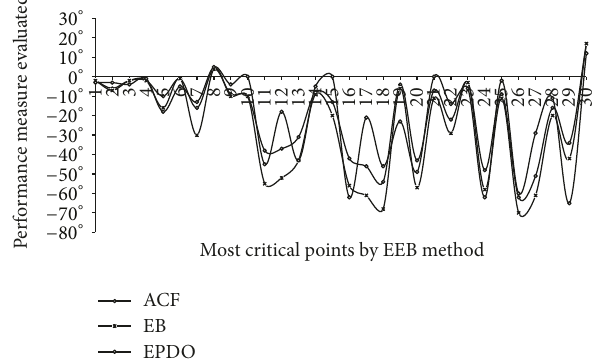
Figure 4: Difference between EEB and ACF and EB and EPDO